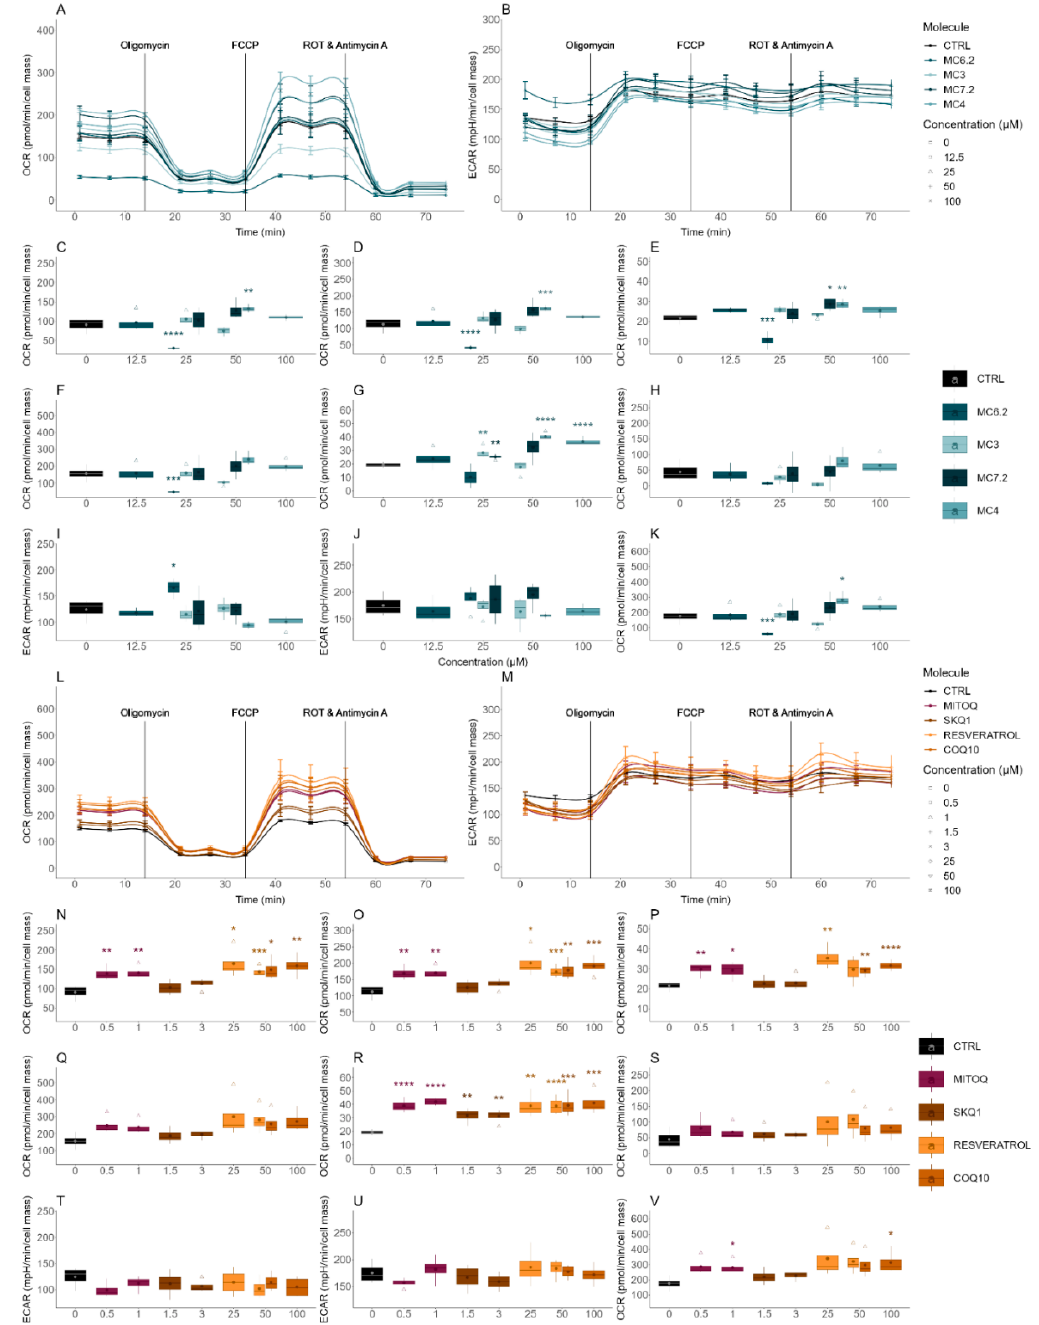
Figure 7. Effect of MitoCINs, quinone-based mitochondria-targeted and non-targeted antioxidants on oxygen consumption rate (OCR) and extracellular acidification rate (ECAR). OCR- and ECAR-associated parameters were assessed with a Seahorse XFe96 Extracellular Flux Analyzer. OCR ( A , L ) and ECAR ( B , M ) were assessed in differentiated human neuroblastoma (SH-SY5Y) cells treated with increasing concentrations of the different molecules for a period of 48 h. Several OCR parameters were evaluated: ATP production-linked OCR ( C , N ), basal respiration ( D , O ), proton leak-based OCR ( E , P ), maximal respiration ( F , Q ), non-mitochondrial respiration ( G , R ) and spare respiratory capacity ( H , S ). ECAR parameters were also evaluated, including basal ECAR ( I , T ), stressed ECAR ( J , U ) and stressed OCR ( K , V ). Data are the mean ± SE of four independent experiments and the results are expressed in the interquartile range (Q1–Q3) together with the ( ⎯ ) median. Statistically significant differences between control (CTL) and treated groups were evaluated using a t -test. **** p < 0.0001, *** p < 0.001, ** p < 0.01 and * p < 0.05 compared to the respective control (CTL).